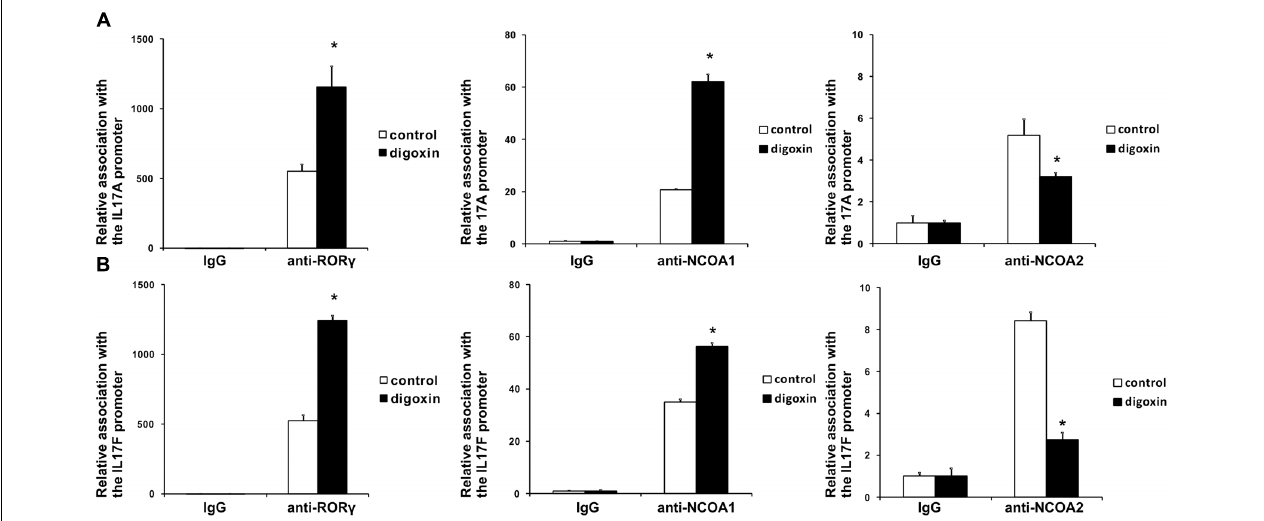
FIGURE 7 | Analysis of the binding of ROR γ T, NCOA1 and NCOA2 in vivo to the promoter sequences of the IL17A (A) and IL17F (B) genes in Th17 cells after treatment with digoxin as evidenced by chromatin immunoprecipitation. Human naive CD4+ cells were treated with 100 nM digoxin, cultured under Th17-polarizing conditions for 5 days and then analyzed using chromatin immunoprecipitation. Mean ± SD, n = 3 (from three different donors), ∗ significantly different from the control treatment at p < 0.05. TABLE 1 | Gene ontology (biological process) term results from the PANTHER overrepresentation test for significantly differentially expressed (DE) genes after digoxin treatment in Th17 cells. GOID GO biological process term Number p -value